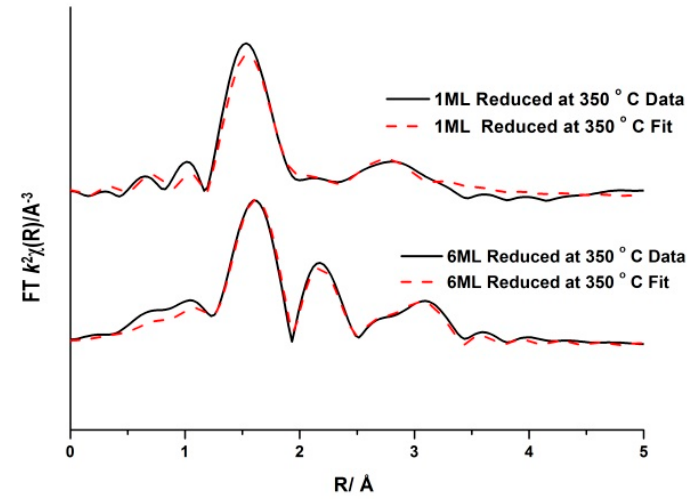
Figure 24. Magnitude component of the k 2 -weighted Fourier Transform for the EXAFS data of the 1 and 6ML MoO x /Fe 2 O 3 catalyst reduced.